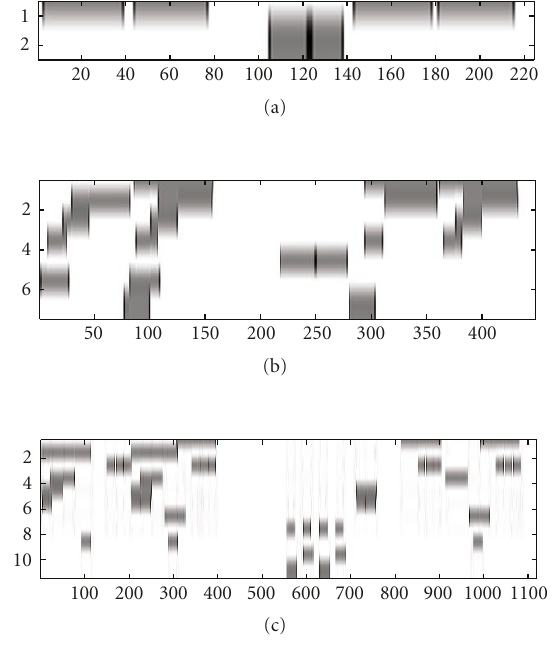
Figure 16: Similarity clusters for the Shostakovich example of Figure 2 resulting from a structure analysis using (a) S min 16 [41,10], (b) S min 16 [21,5], and (c) S 16